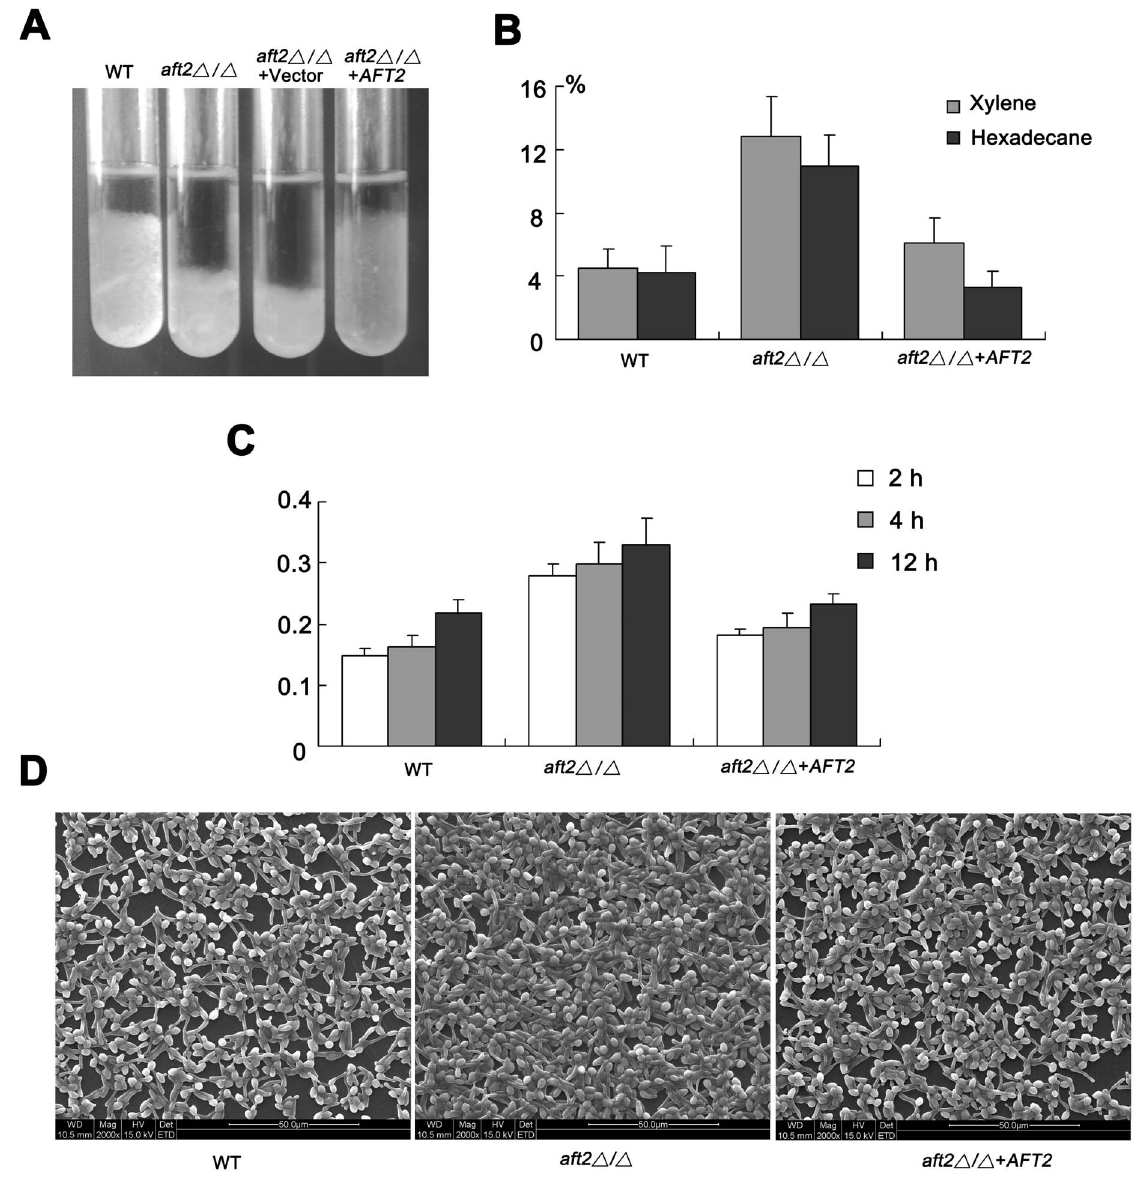
Figure 6. Influence of AFT2 on surface properties in C.albicans . (A) The strains indicated were cultivated in RPMI 1640 medium to mid- exponential phase at 37 u C. All tubes were vigorously vortexed, and cells were allowed to settle for 10 min before the flocculation observation. (B) Cell surface hydrophobicity was determined by the hydrocarbon/water partition method with xylene and hexadecane. Data indicate mean values 6 standard deviations from three independent experiments performed in triplicates. (C) After 2 h, 4 h and 12 h incubation, the ability of adhesion to polystyrene was assessed through the quantification of total biomass by crystal violet staining. (D) The SEM assay was performed after 12 h incubation in a 24-well cell culture